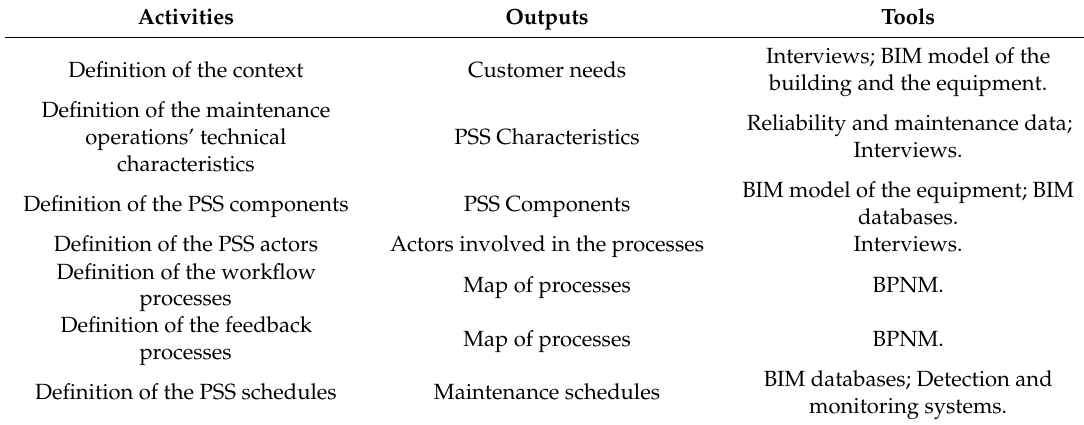
Table 1. Activities and tools for the development of an integrated BIM-PSS maintenance